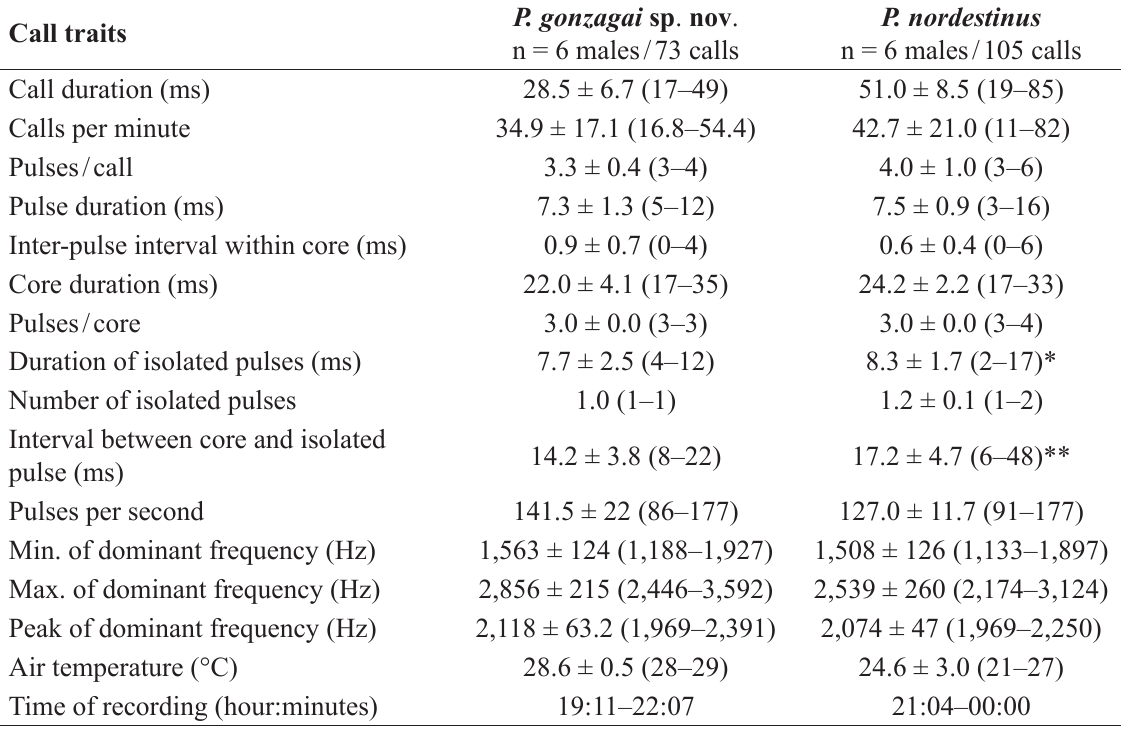
Table 2. Advertisement call traits of two sister species of leaf frogs: Pithecopus gonzagai sp. nov. and P. nordestinus (Caramaschi, 2006). Values presented as mean ± SD (range). * = mean of two isolated pulses; ** = mean of two inter-pulse